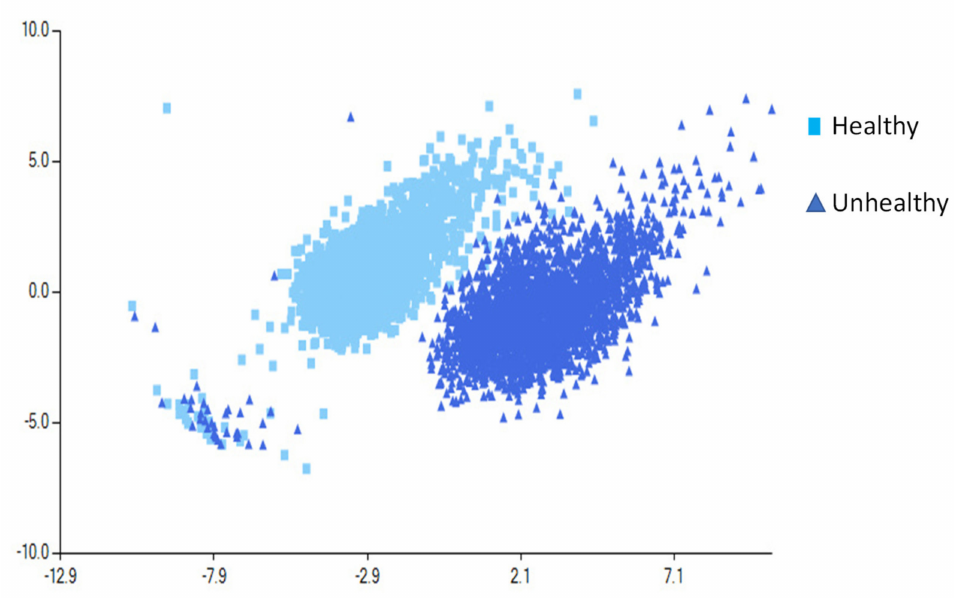
Figure 11. Feature distribution map of the first machine